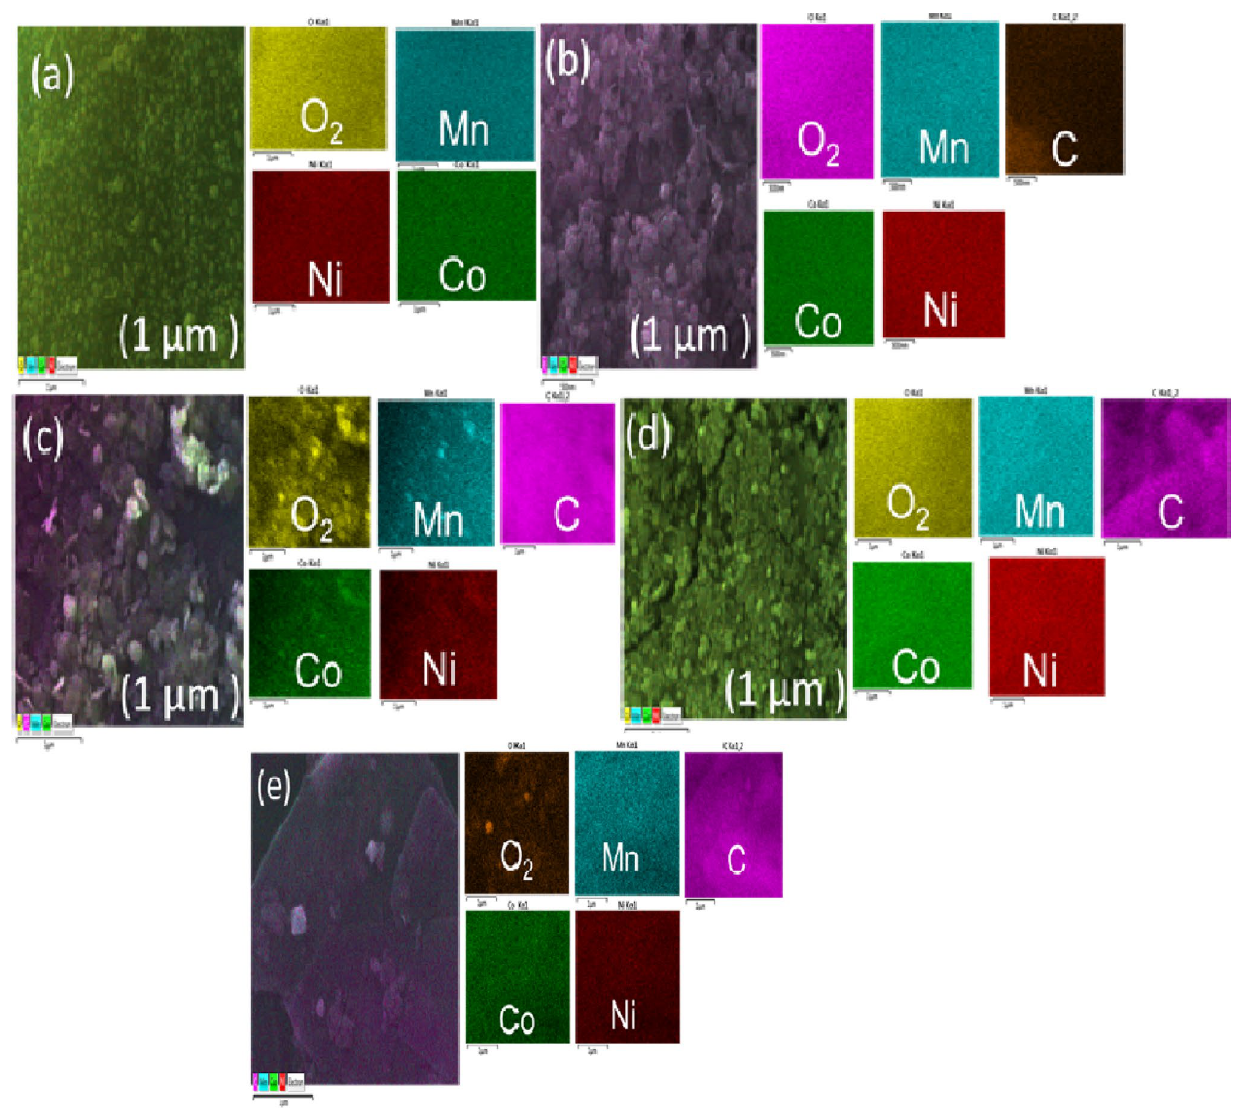
Fig. 5 EDX mapping of a NiCoMn-TH (pristine), b NiCoMn TH/100 mg GF, c NiCoMn-TH/150 mg GF, d NiCoMn-TH/200 mg GF, and e NiCoMn-TH/250 mg,